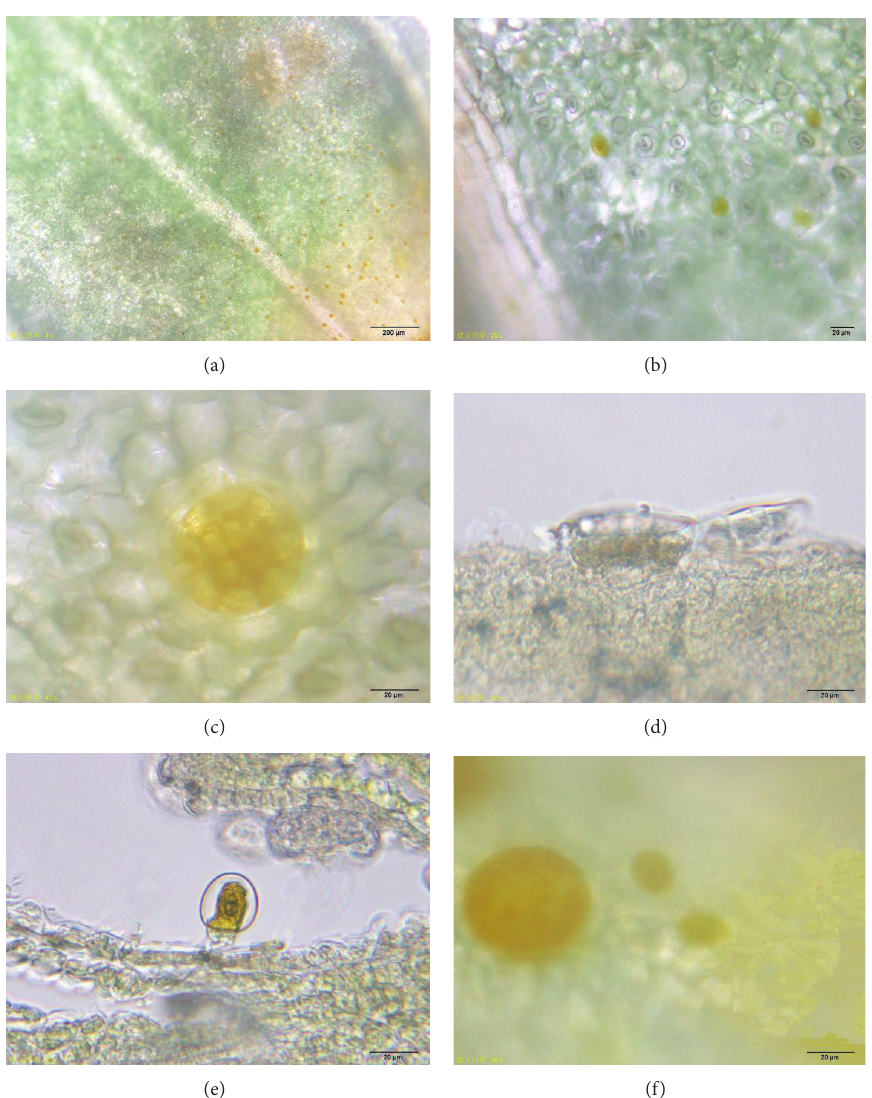
Figure 3: (a)-(b) Surface view of young leaves of T. quinquecostatus . (a) A lot of capitate trichomes dyed yellow. (b) Peltate trichomes showed colourless after dyed. (c) A peltate trichome showed yellow after dyed. (d) Transverse section of a young leaf of T. quinquecostatus, showing the head of a peltate trichome dyed yellow. (e) Transverse section of a young leaf of T. quinquecostatus, showing the head of a capitate trichome dyed yellow. (f) Surface view of a nearly mature leaf of T. quinquecostatus , showing capitates trichomes and the peltate trichomes dyed